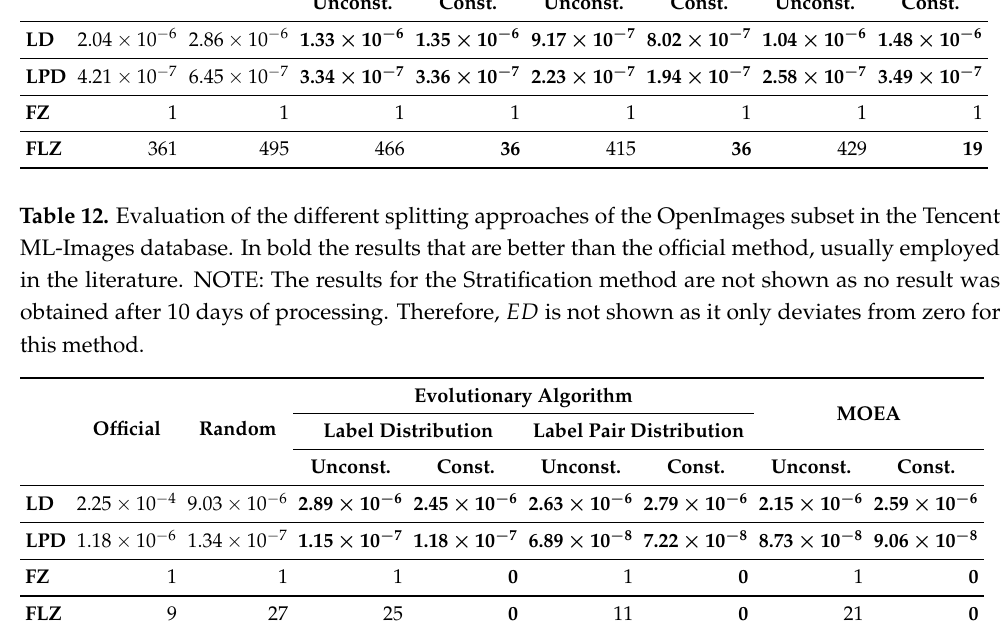
Table 11. Evaluation of the different splitting approaches of the Imagenet subset in the Tencent ML-Images database. In bold the results that are better than the official method, usually employed in the literature. NOTE: The results for the Stratification method are not shown as no result was obtained after 10 days of processing. Therefore, ED is not shown as it only deviates from zero for that method. Evolutionary Algorithm MOEA Official Random Label Distribution Label Pair Distribution Unconst. Const. Unconst. Const. Unconst. Const.